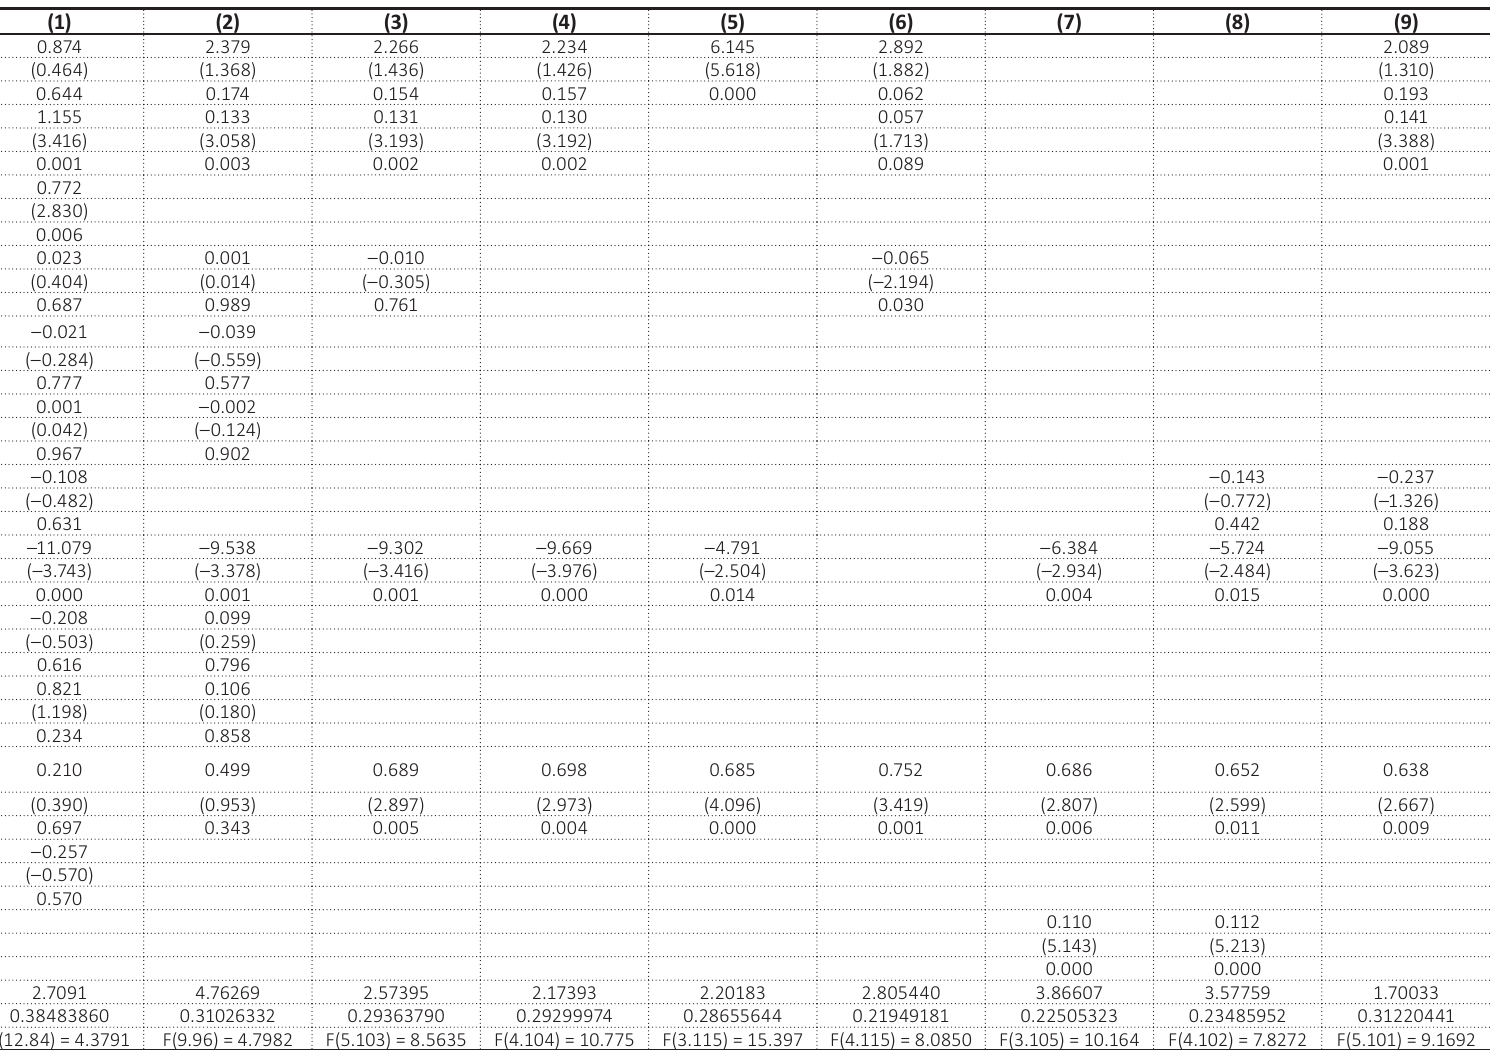
Table 2. Multi-factor regression analysis